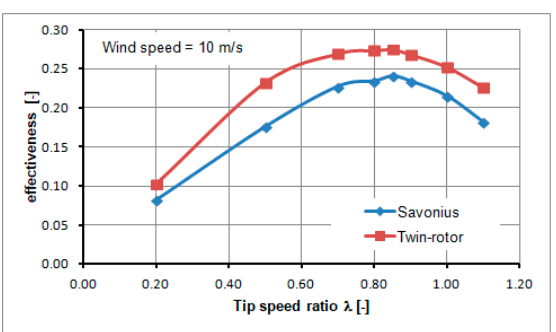
Figure 10. Comparison of rotor characteristics at wind speed of 10 m/s.